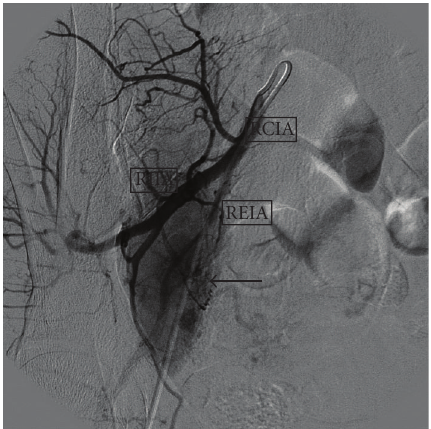
Figure 3: Selective right iliac arteriography prior to embolization, that demonstrates pront enhancement of the lesion (arrow) after contrast infusion. RCIA: right common iliac artery, REIA: right external iliac artery, RIIA: right internal iliac